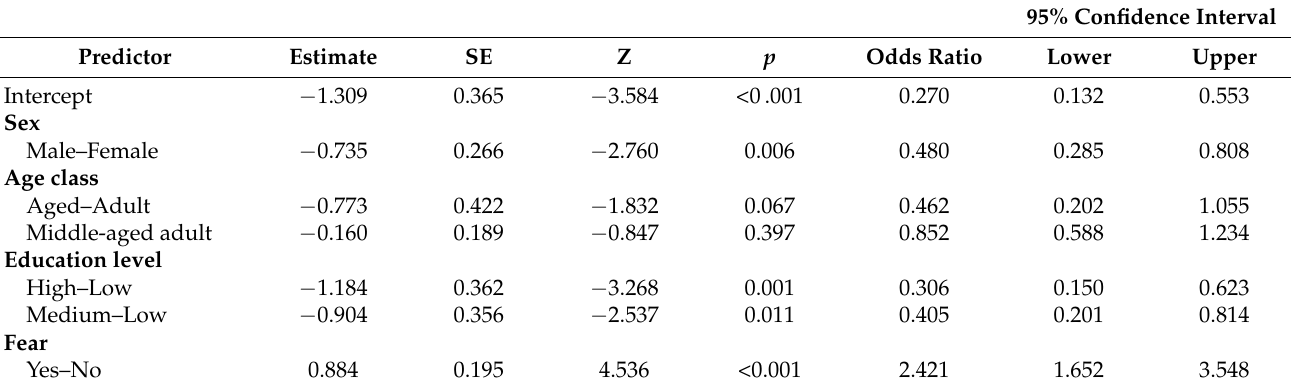
Table A7. Results of Multivariate Regression Analysis Models, with Quality of Sleep as Dependent Variable and Feeling of Fear and Sociodemographic Characteristics as Independent Variables.